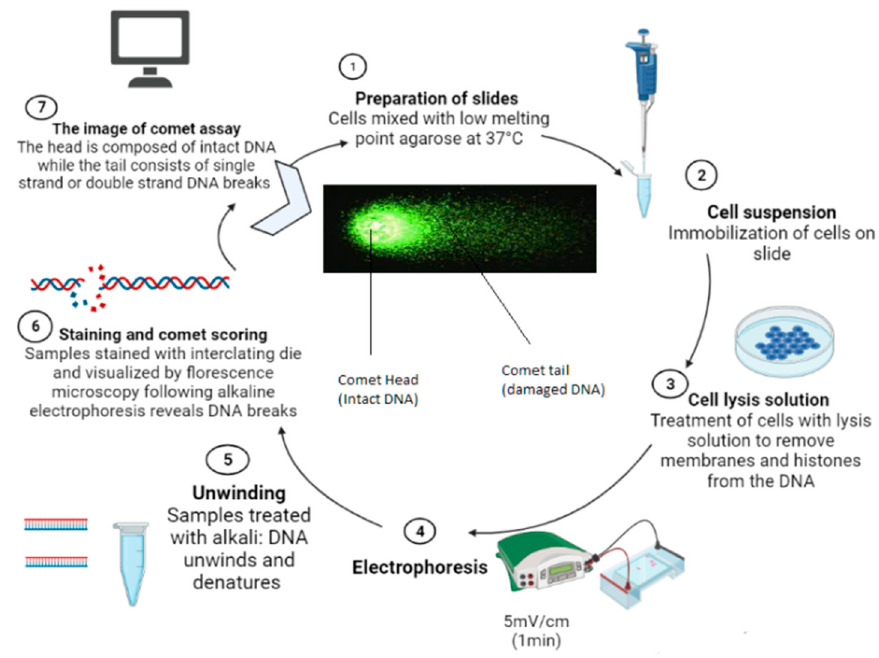
Figure 1. Schematic diagram showing methodology of comet assay.